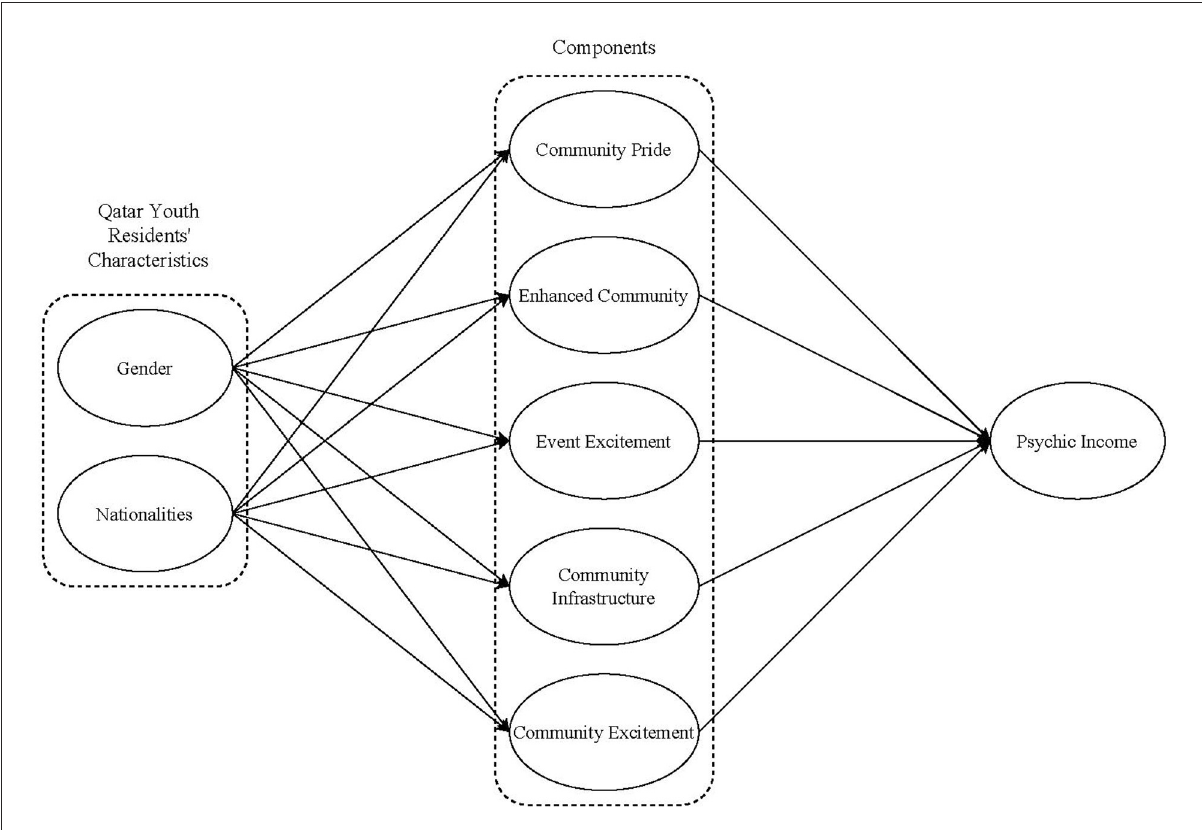
FIGURE1 Conceptual